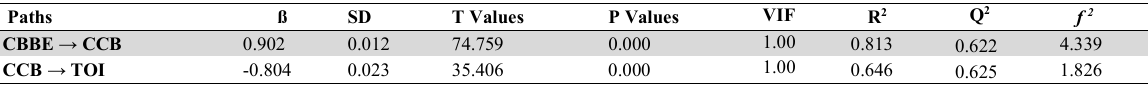
Direct Paths Assessment